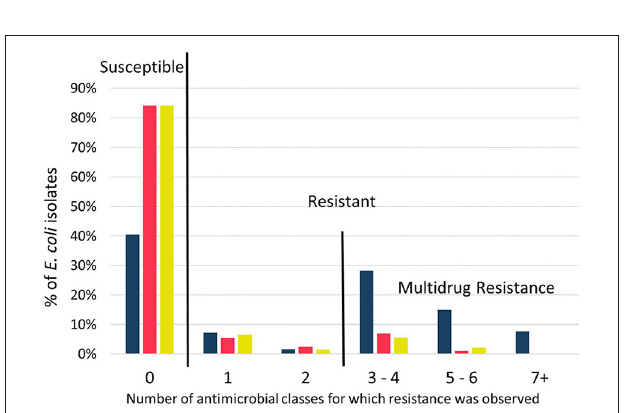
FIGURE 4 | Distribution of susceptible and resistant profiles for Escherichia coli isolated from calves ( ; n = 195), cows ( ; n = 202), and manure pits ( ; n = 196) from 101 dairy farms from Québec Province, Canada. Columns above zero were susceptible to all antimicrobials tested. Columns above a number > 0 were resistant to that corresponding number of antimicrobial classes. Multidrug resistance was defined by resistance to three or more antimicrobial classes. Globally, distribution of isolates from calves were statistically different from isolates of cows and manure pits ( p < 0.05; Poisson regression with Tukey-kramer correction for multiple comparison).